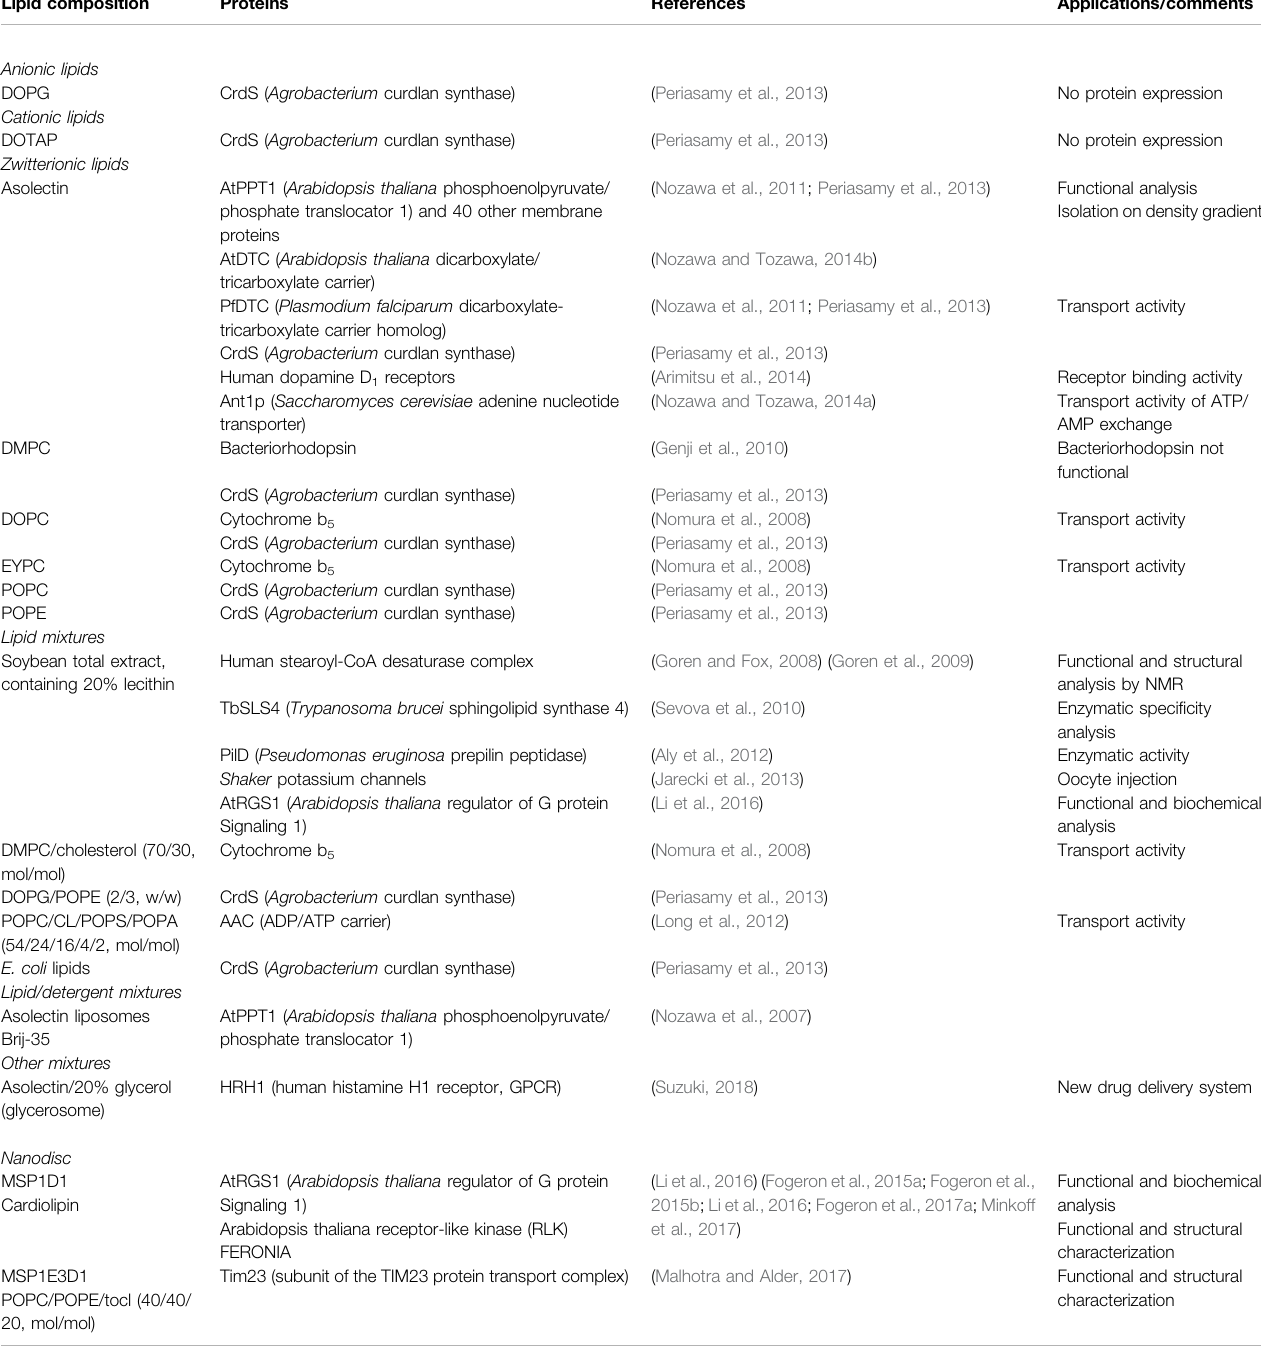
TABLE 5 | Summary of lipids whose use has been described for the production of membrane proteins with the WGS. Lipid